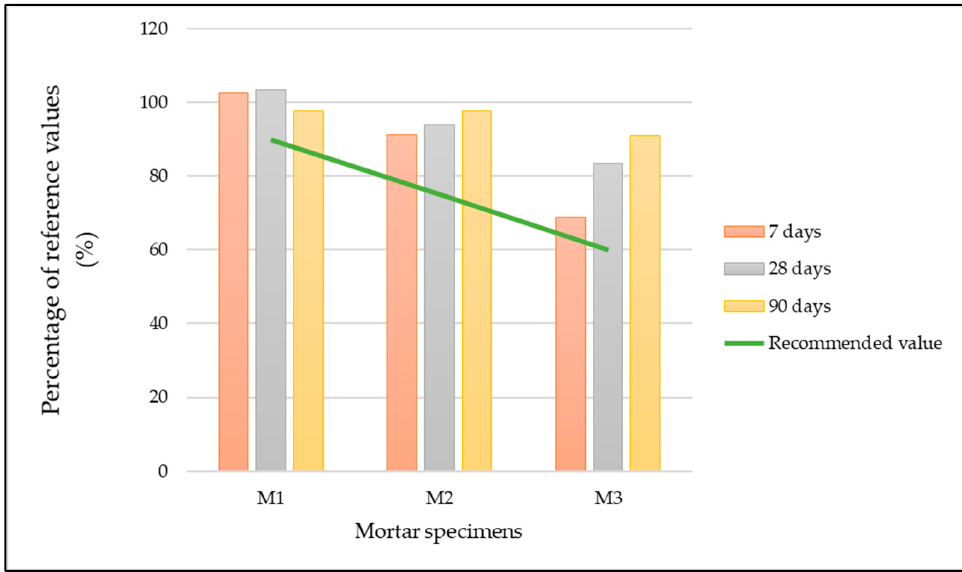
Figure 6. Comparison with recommended values.